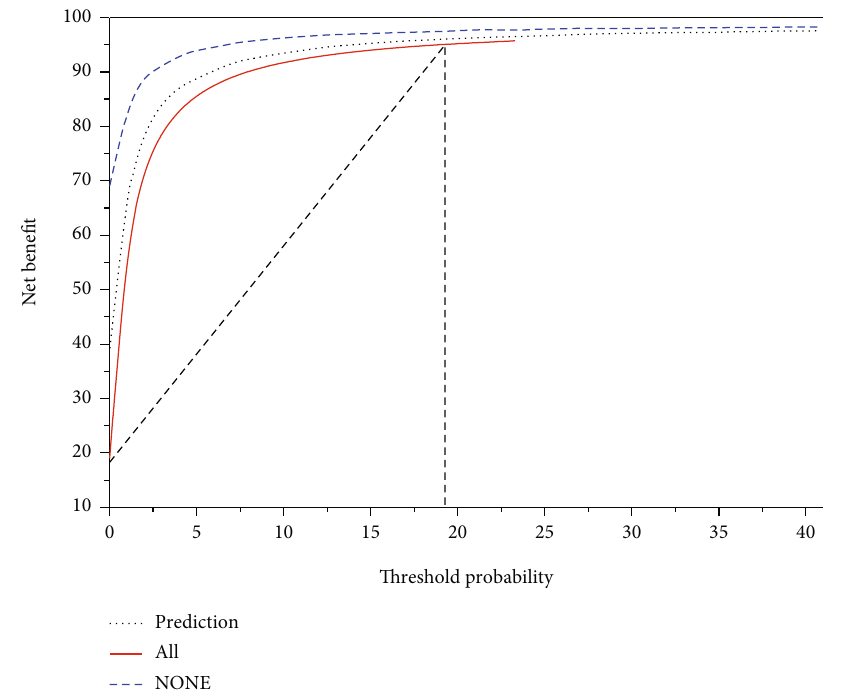
Figure 1: Column line diagram clinical decision